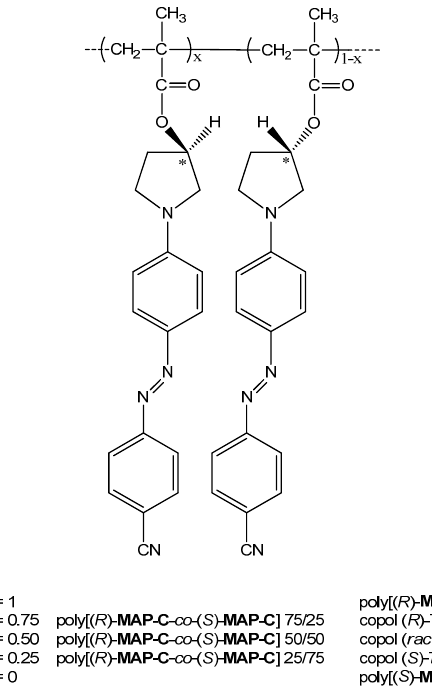
Figure 1. Chemical structure of the investigated azobenzene derivatives.